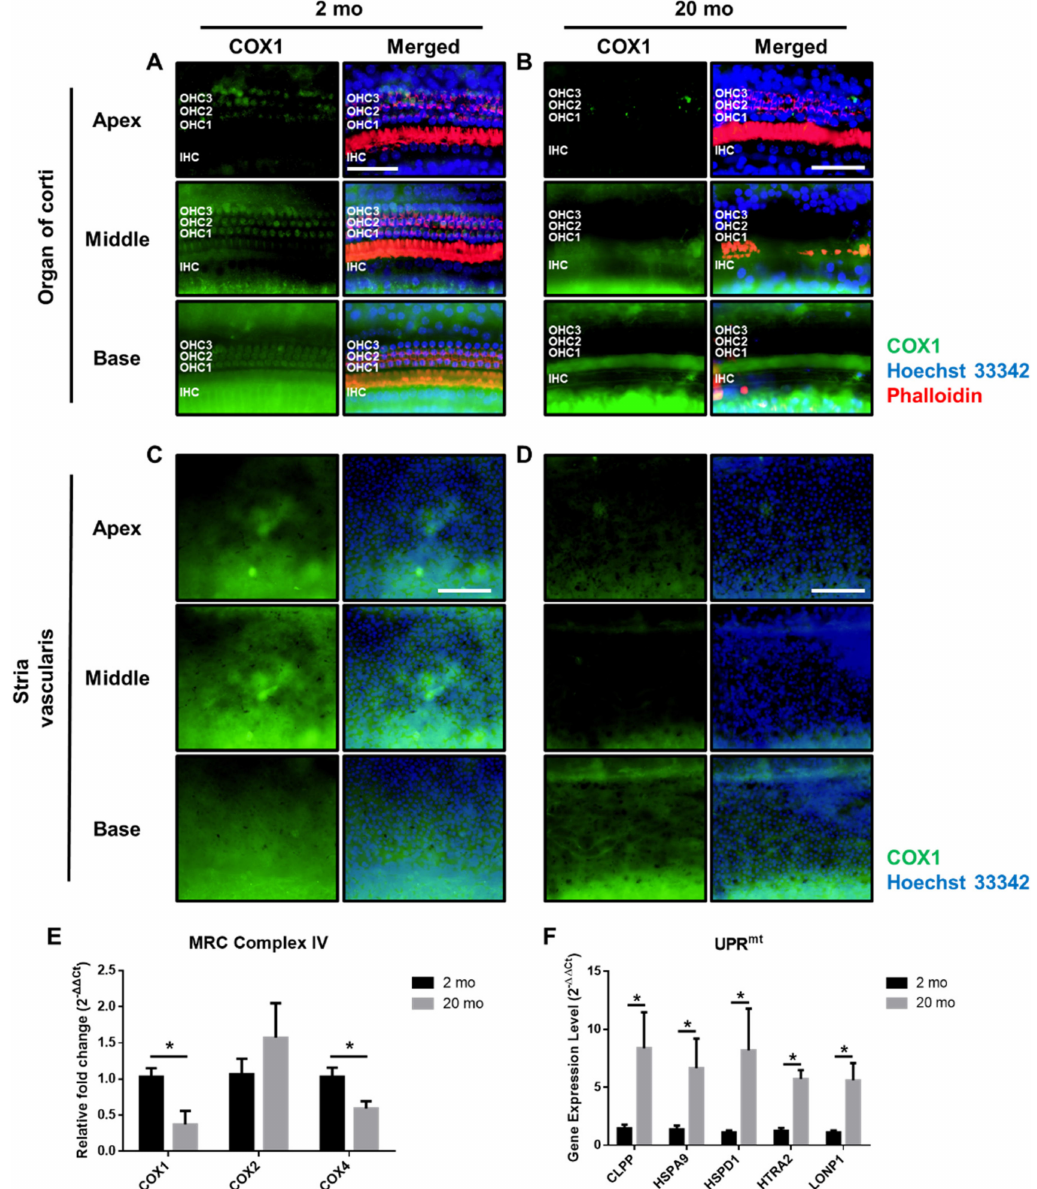
Figure 6. Mitochondrial respiratory chain complex IV and stress responses in young and aged mice. ( A – D ) Whole mounts of the auditory epithelium were triple-stained with a Hoechst33342 (blue) specific for nuclei, fluorescence-tagged antibodies against cytochrome C oxidase I (COX1, green) and phalloidin (red) from apex, middle, and base turns of organ of Corti and stria vascularis. Aged auditory epithelium ( A , B ) and stria vascularis ( C , D ) show a decreased COX1 protein expression. Scale bar represents 100 µ m. ( E ) Genes in mitochondrial respiratory chain complex IV in young and aged mice. Aging cochlea expresses significantly decreased COX I and COX IV levels. ( F ) Gene expression levels of mitochondrial unfolded protein response (UPR) markers in young and aged cochlea. GAPDH was used as a reference gene. Graphs represent mean ± S.E.M. * p < 0.05. Unpaired t -test. n = 5–8. IHC, inner hair cell; OHC1-3, three rows of outer hair